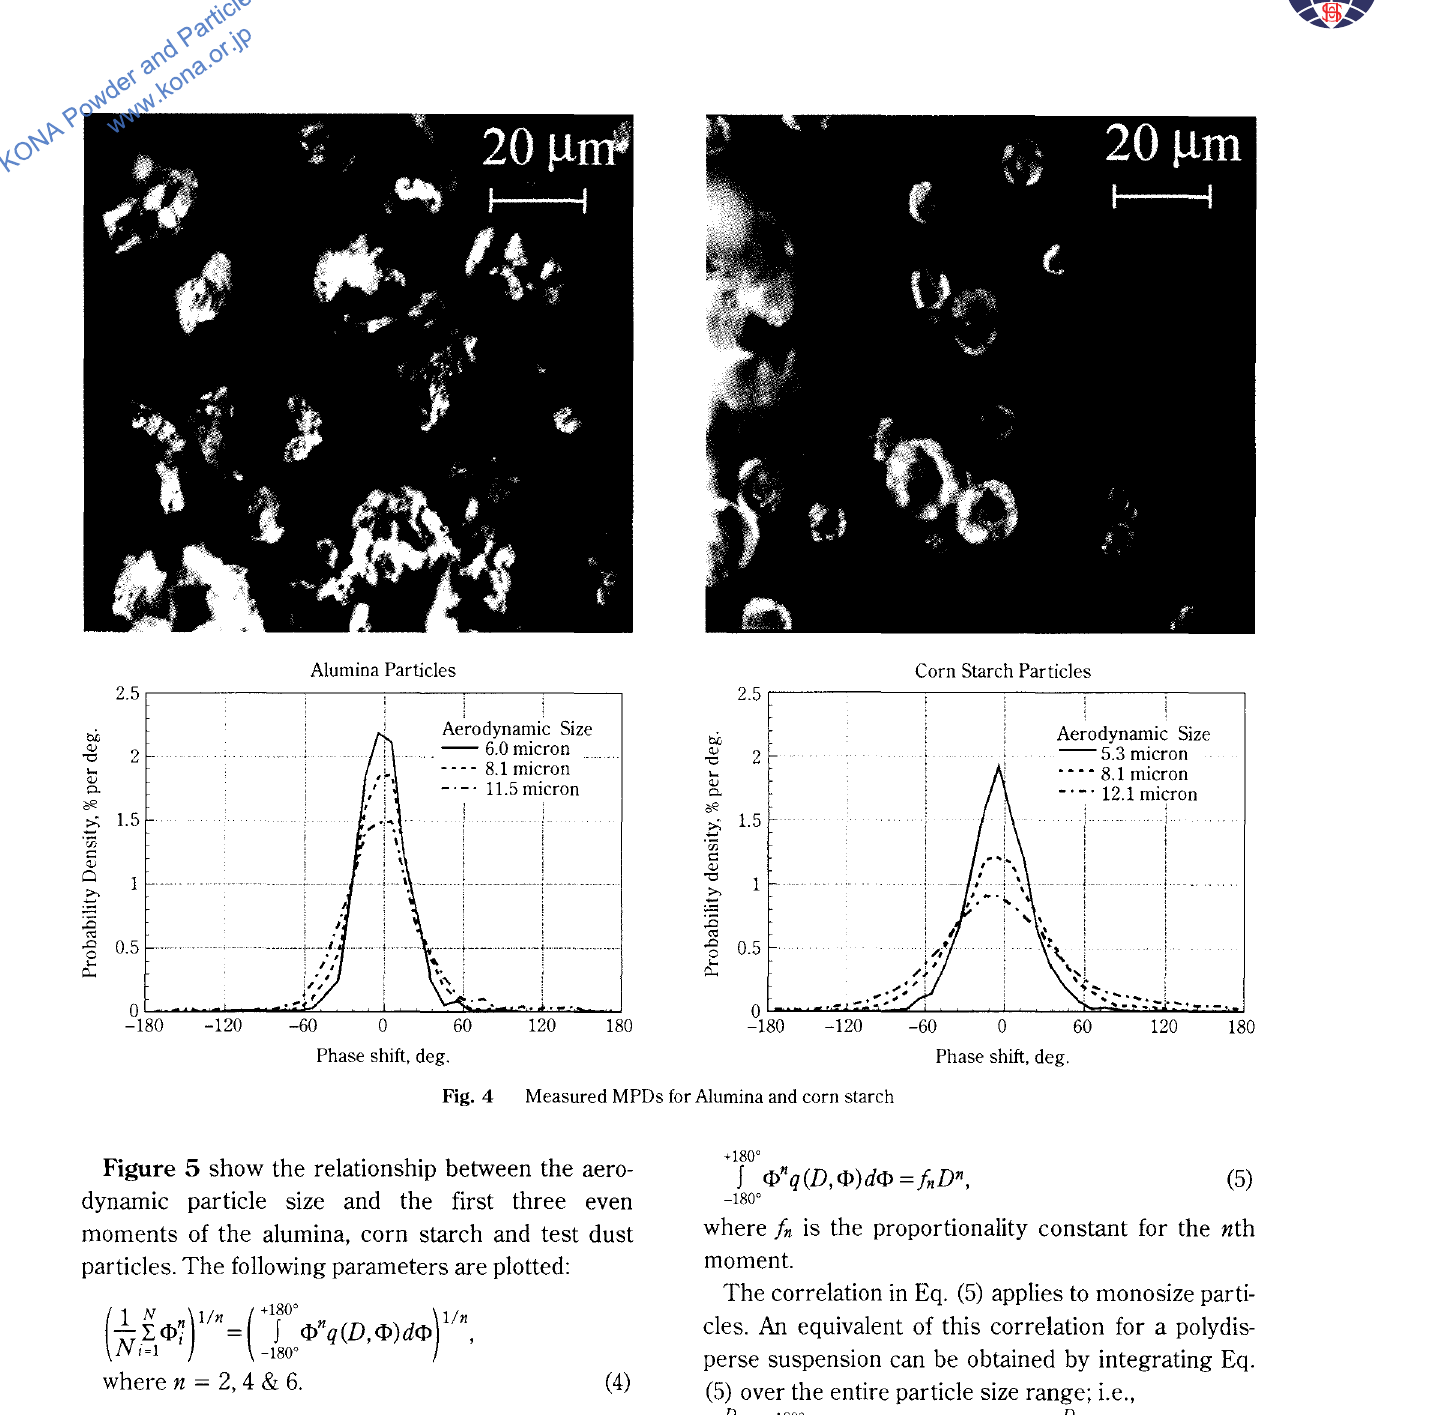
Alumina Particles Corn Starch Particles 2.5